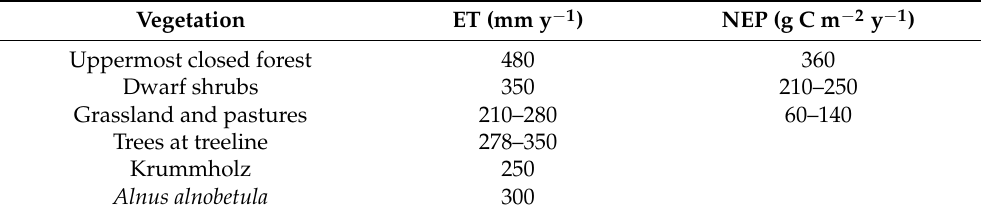
Table 2. Year-round evapotranspiration (ET) and net ecosystem production (NEP) of various vegeta- tion types within the treeline ecotone of the Central Tyrolean Alps. Compiled after [60–68].